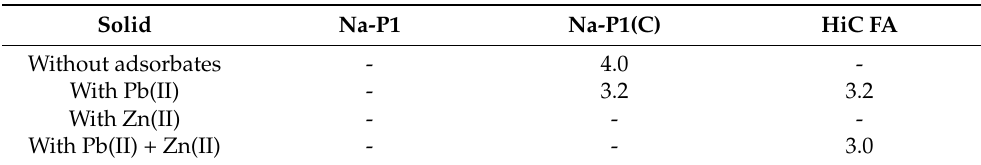
Table 6. Comparison of the pH iep values of the HiC FA, Na-P1, Na-P1(C) particles in the absence or presence of heavy metal